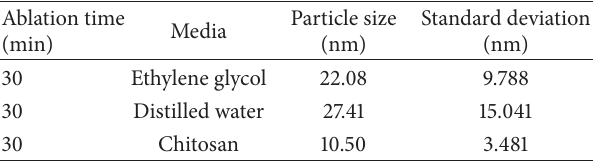
Table 1: Particle size of Ag-NPs with their standard deviation for particle of size (nm) in ethylene glycol and distilled